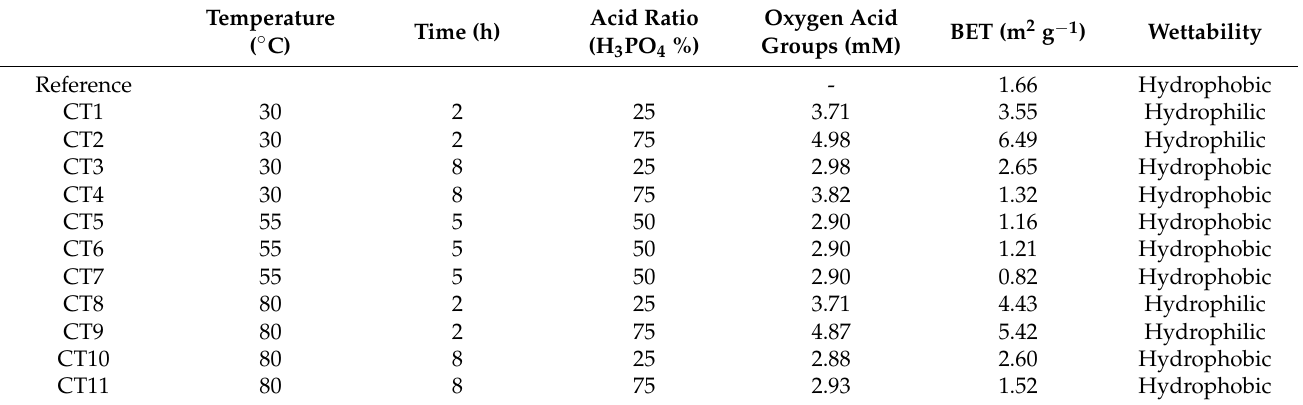
Table 2. Experimental conditions and measured parameters for chemical